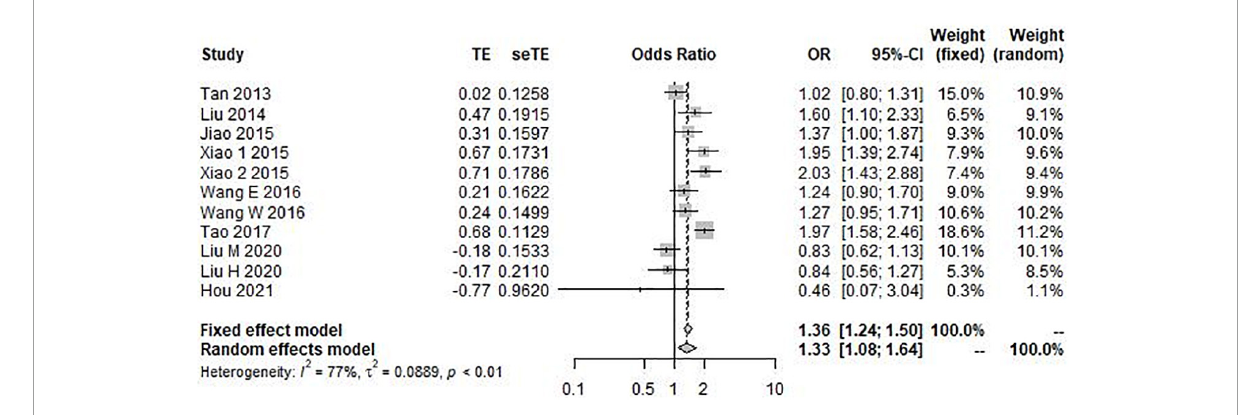
FIGURE2 Forest plot for the meta-analysis of the rs9349407 polymorphism using the allele model.